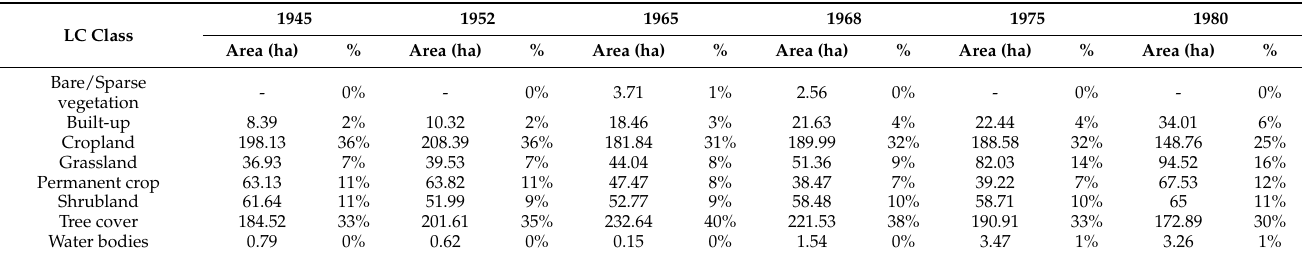
Table 9. Temporal evolution of the LULC classes in Ruen from 1945 to 1980 (in absolute numbers and